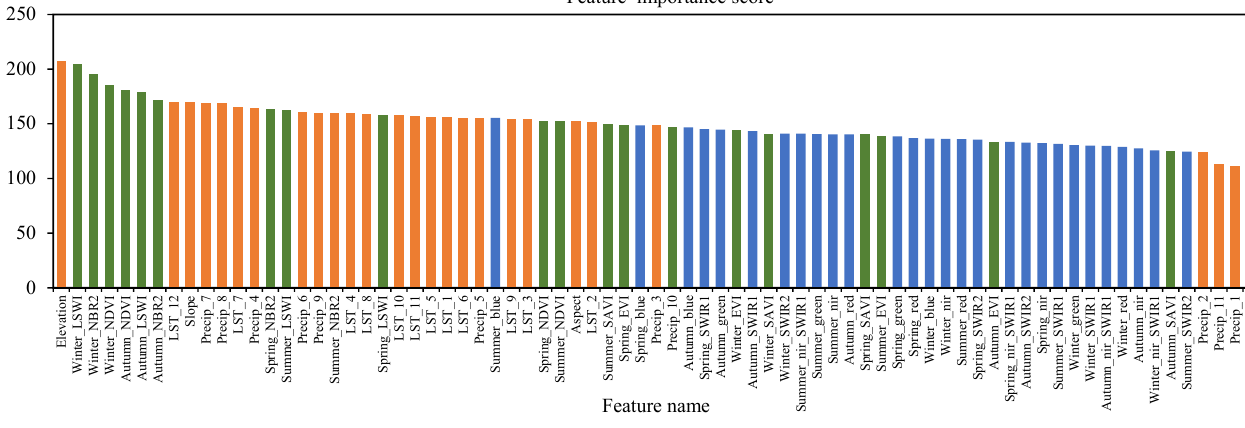
Figure 5. The feature importance score for five forest types classified using the combination of multi- seasonal spectral reflectance and vegetation index, terrain (elevation, slope, and aspect), temperature, and precipitation features. The features are colored according to the feature type: orange indicates environmental factors (27 variables), green indicates vegetation indexes (20 variables), and blue indicates spectral reflectance features (28 variables).